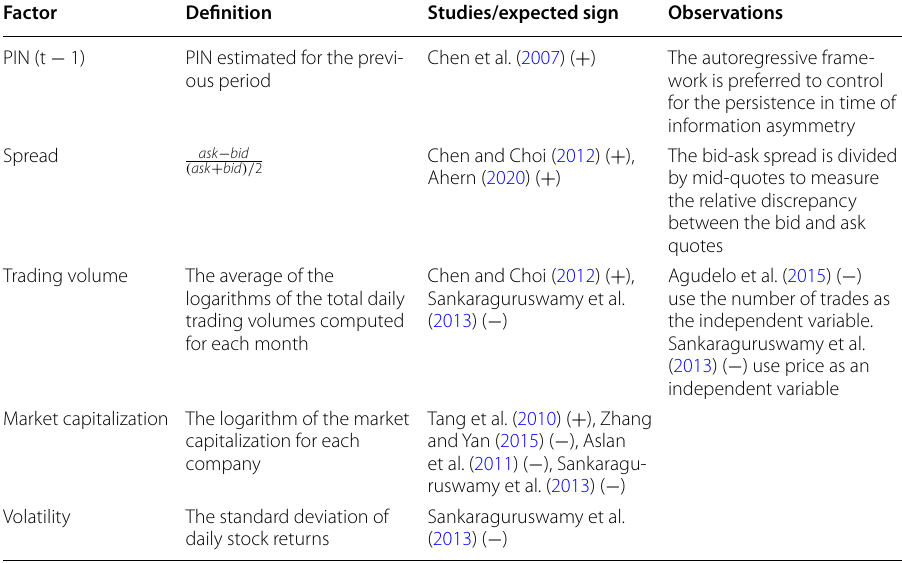
Table 1 Studies on the determinants of PIN